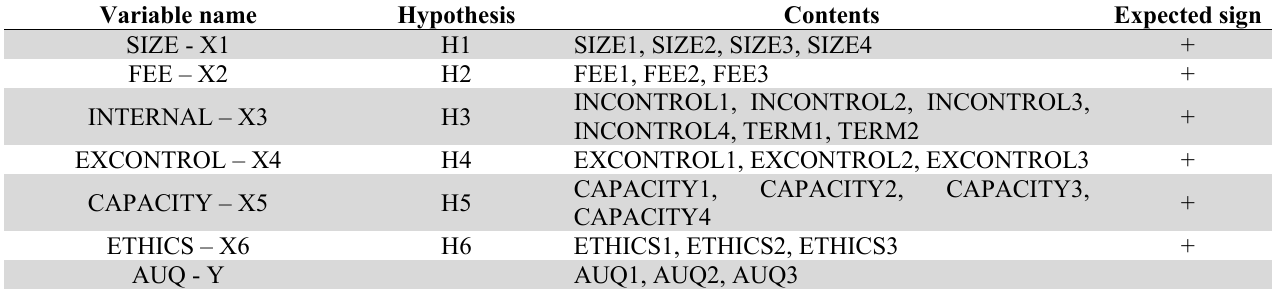
Summary of research hypotheses 2 of independent variables to Audit